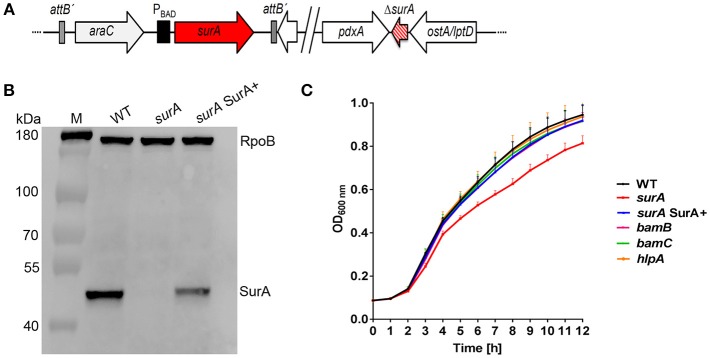
Scheme of the conditional surA mutant, verification and impact of SurA, BamB, BamC and HlpA on Pa growth. (A) Schematic view of the genomic organization of the conditional surA mutant. (B) Western blot analysis of SurA and RpoB of PA14 WT and the conditional surA mutant in the absence (surA) and presence of 0.2% arabinose (surA SurA+). (C) Growth curves of indicated strains. Data depict the mean and SD of at least 3 experiments. Growth curve of the conditional surA mutant is highlighted in red. ANOVA analyses revealed significant differences (p < 0.01) for both WT vs surA and surA SurA+ vs surA in the time range between 6 and 12 h.